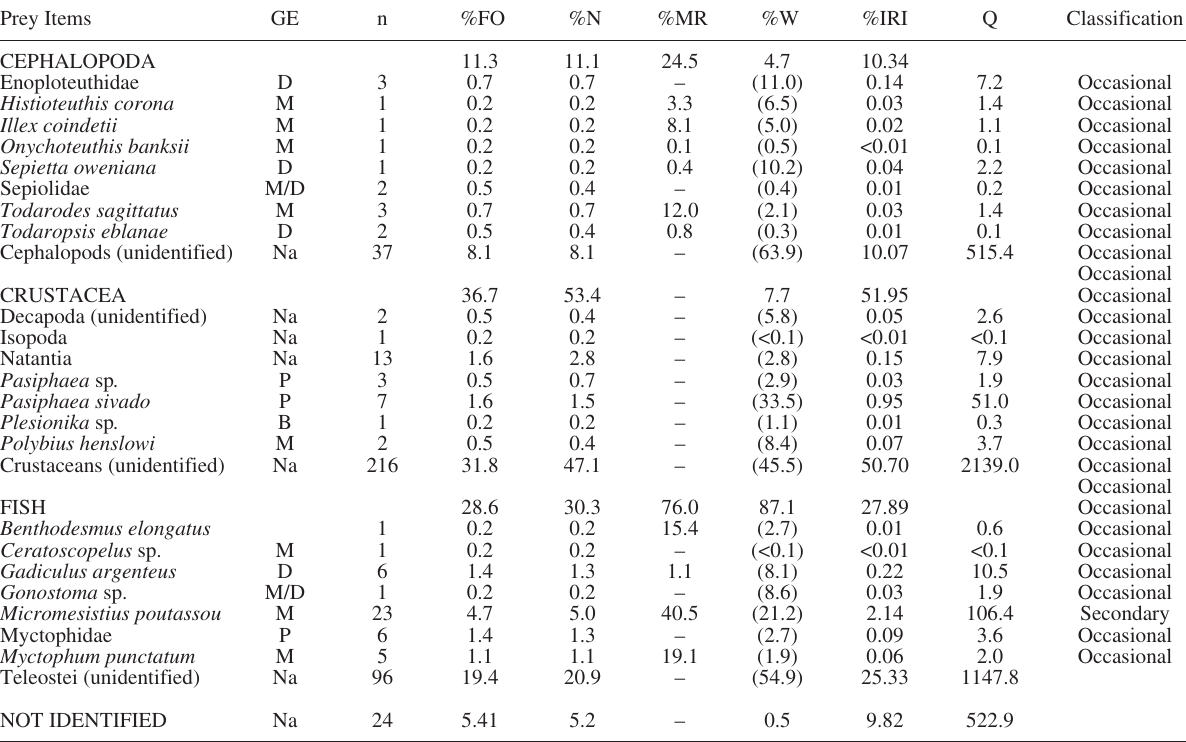
Table 2. – List of identified prey categories in the diet of Etmopterus pusillus (number of individuals with food in their stomachs=443) combining data from both trawl and longline gears. GE: ecological group (D: demersal, M: mesopelagic, P: pelagic, B: benthic, Na: not attributable); n: number of prey; %FO: frequency of occurrence; %N: percentage in number; %MR: percentage by reconstructed mass %W: percentage by dry weight (estimated mass within each component is in parentheses); %IRI: index of relative importance; Q: food coefficient; and prey